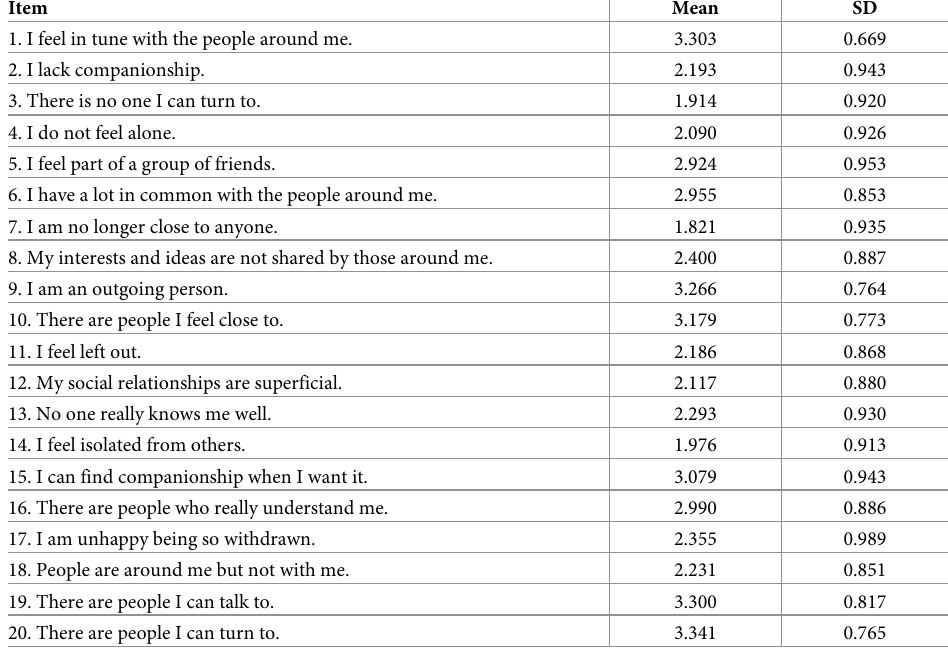
Table 2. Descriptive statistics of questionnaire items (1-4 scale) (Russell, 1996), Sample 2 (older adults, n = 290). Item Mean SD